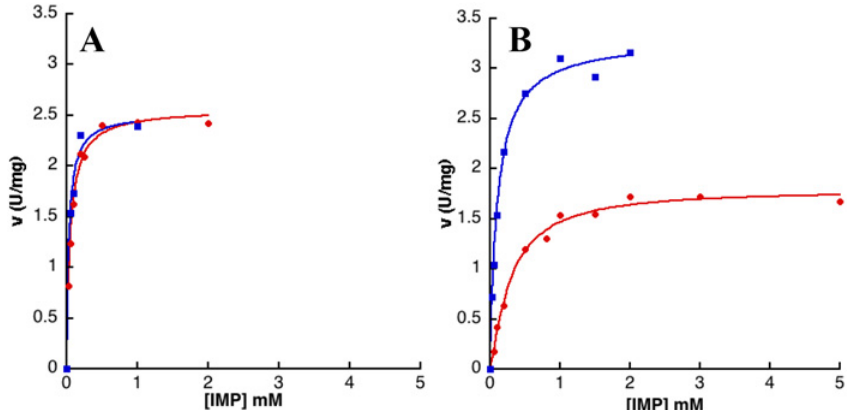
Fig 4. IMPDHbt (A) and IMPDHlpp (B) activity versus IMP concentration. Enzyme activity was determined at a fixed concentration of NAD (2 mM for IMPDHbt and 6 mM for IMPDHlpp), and in the absence (red curve) or in the presence (blue curve) of 5 mM MgATP. The curves correspond to the fit of the experimental data to the Michaelis-Menten equation for IMPDHbt and Hill equation for IMPDHlpp and the calculated parameters are displayed in Table 5.